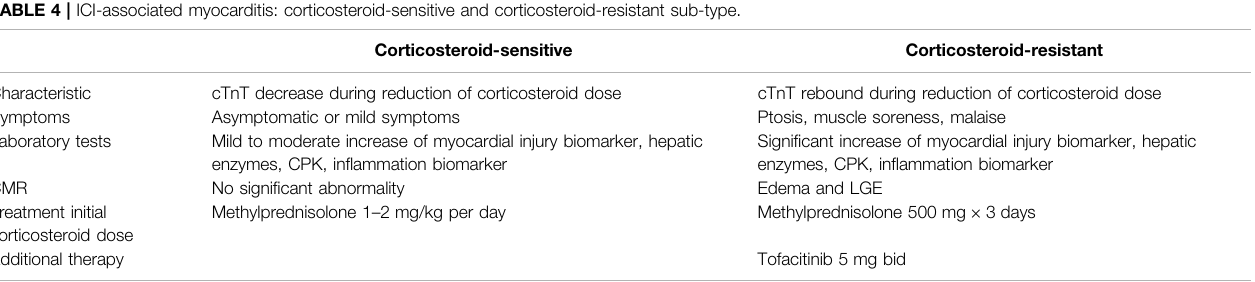
TABLE 4 | ICI-associated myocarditis: corticosteroid-sensitive and corticosteroid-resistant